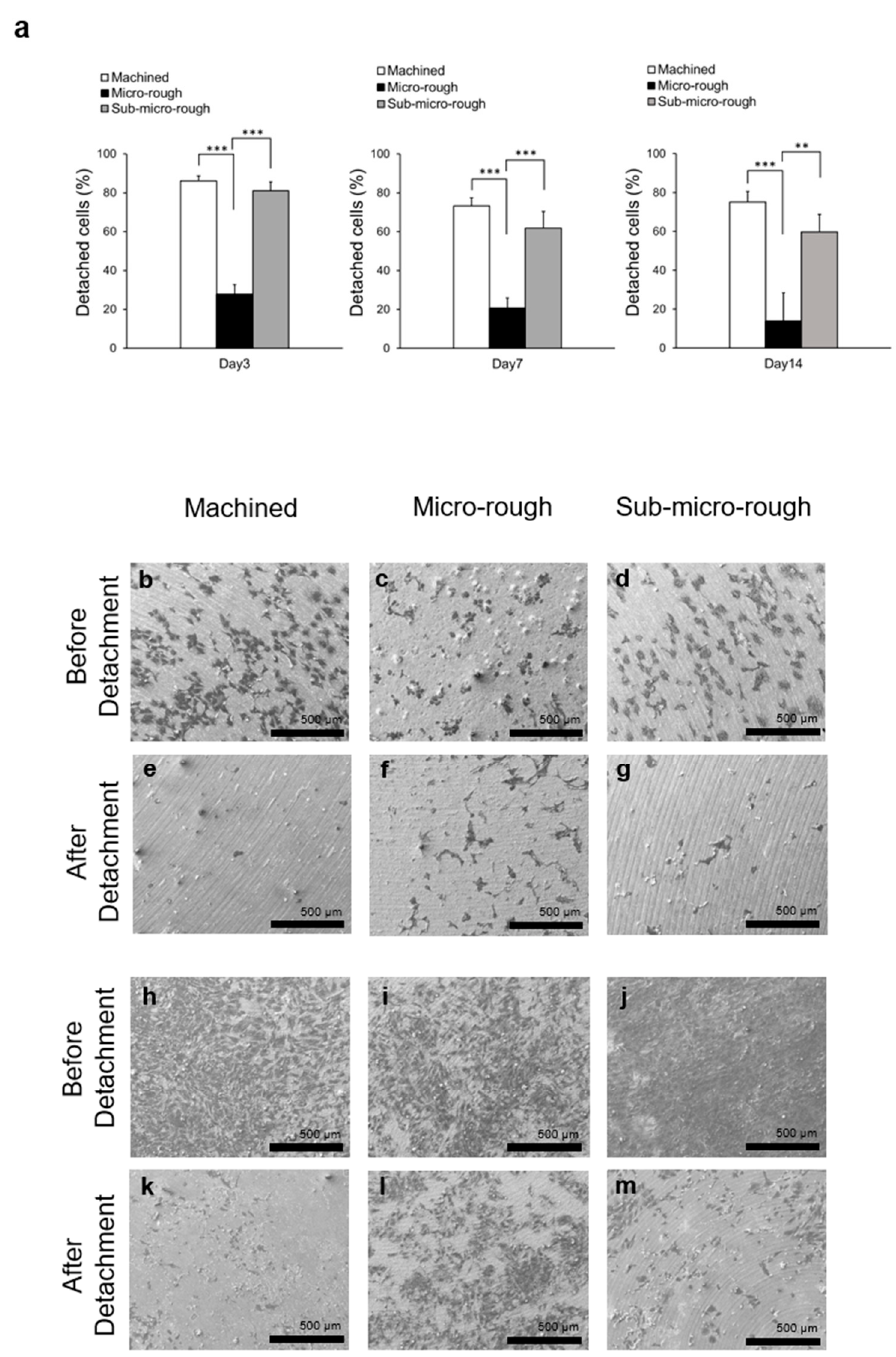
Figure 4. Results of detachment assay on three di ff erent titanium surfaces. ( a ) The percentage of detached osteoblasts from three di ff erent titanium surfaces after incubation for 3, 7, and 14 days. Each value represents the mean ± standard deviation of triplicate experiments ( n = 3). ** p < 0.01, *** p < 0.001, one-way ANOVA followed by Tukey’s test. ( b – d ) Representative scanning electron microscopy (SEM) photographs of osteoblasts before detachment from three di ff erent titanium surfaces on day 3 of culture. ( e – g ) Representative SEM photographs of osteoblasts after detachment from three di ff erent titanium surfaces on day 3 of culture. ( h – j ) Representative SEM photographs of osteoblasts before detachment from three di ff erent titanium surfaces on day 14 of culture. ( k – m ) Representative SEM photographs of osteoblasts after detachment from three di ff erent titanium surfaces on day 14 of culture. Scale bar = 500 µm.